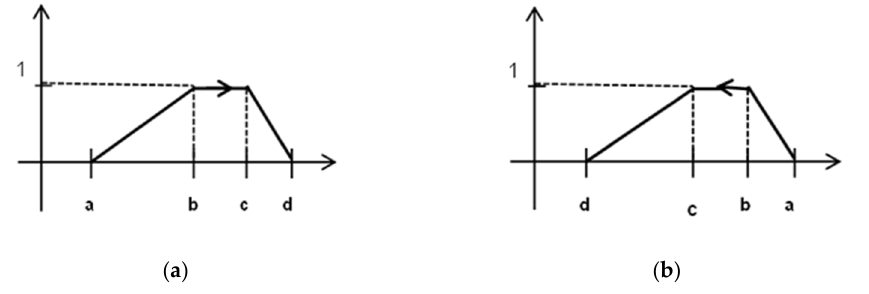
Figure 2. The membership function of ordered FN with: ( a ) A positive orientation, ( b ) a negative